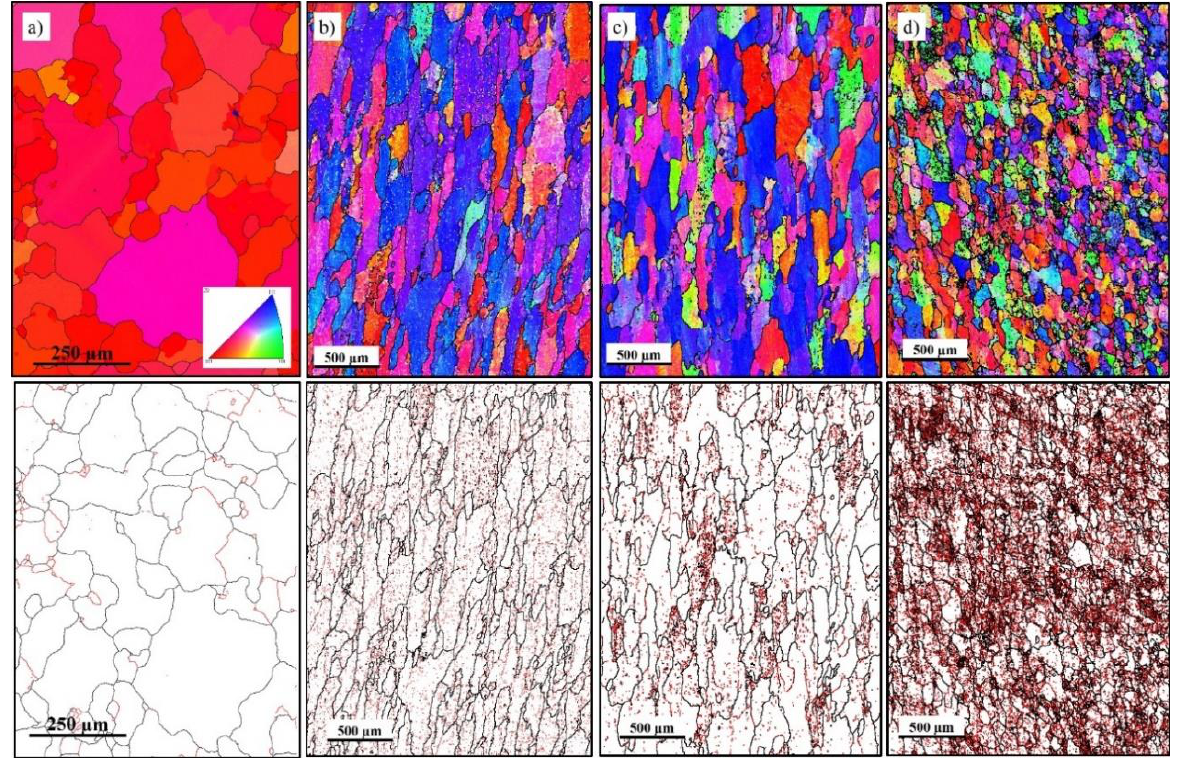
Figure 11. Inverse Pole figure coloring maps and their corresponding grain boundary maps for the BM AA2011 ( a ) and the ECAP processed AA2011 for different passes, ( b ) 1- p , ( c ) 2-Bc, ( d ) 4-Bc.